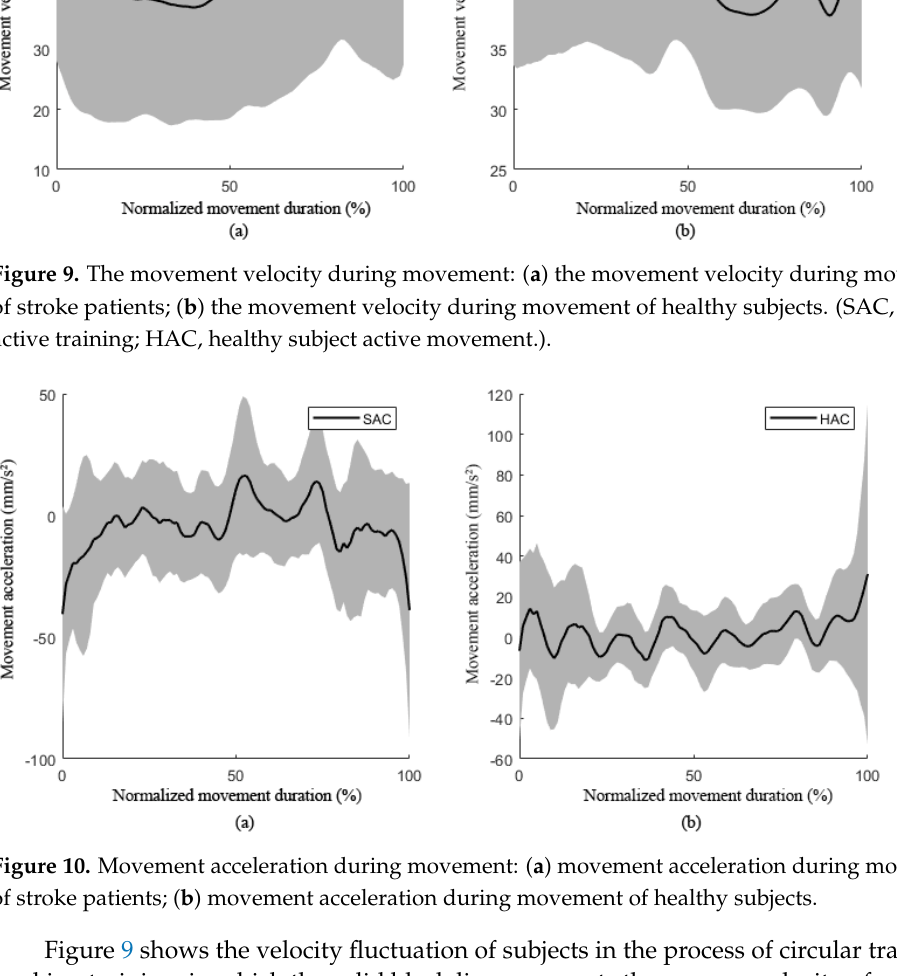
Figure 11. Movement deviation during movement: ( a ) movement deviation during movement of stroke patients; ( b ) move- ment deviation during movement of healthy subjects. 4.5.3. Correlation Analysis Table 3 reports the results of the Pearson correlation analysis between clinical FMU and characteristic parameters. In the case of circular trajectory tracking experiments,